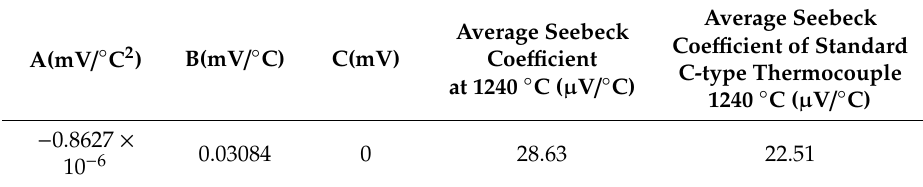
Table 2. Polynomials coe ffi cients of the